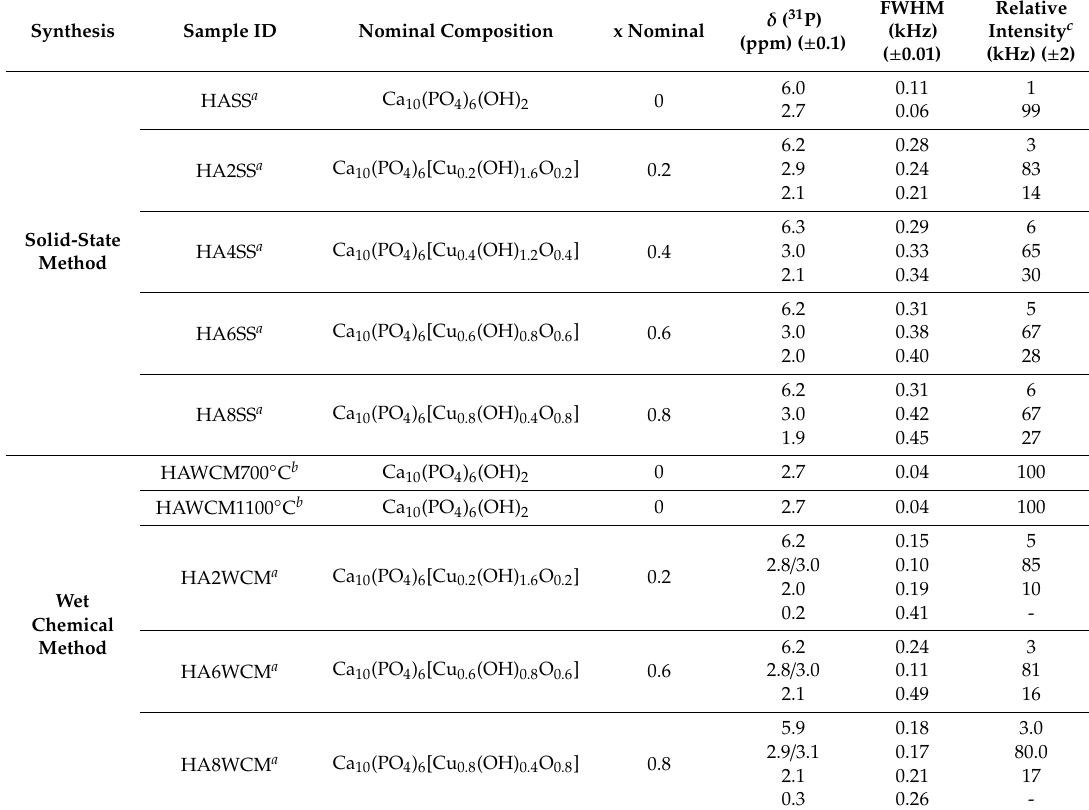
Figure 7. X-ray absorption spectra (XAS) data from x = 0.6 slow-cooled HA6SS1 sample compared to that derived from the air quenched H6SS and HA6WCM samples and Cu 2 O and CuO reference materials. Table 2. 31 P MAS NMR chemical shift, linewidth and relative intensity parameters determined from the solid-state and wet chemical synthesised Cu-doped HA systems (Ca 10 (PO 4 ) 6 [Cu x (OH) 2-2x O x